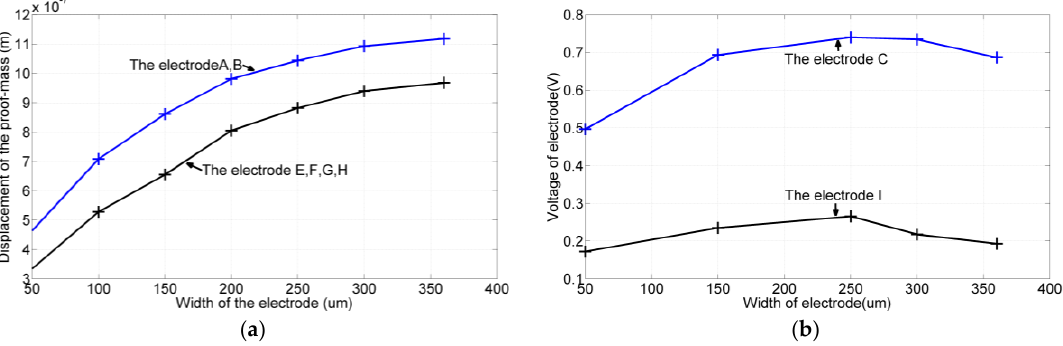
Figure 6. Simulation results. ( a ) Displacement of the proof mass varied with the widths of the drive electrode pairs ( A , B ), ( E , F ), and ( G , H ). ( b ) Voltage output of electrodes C , D , and I – L varied with their widths.